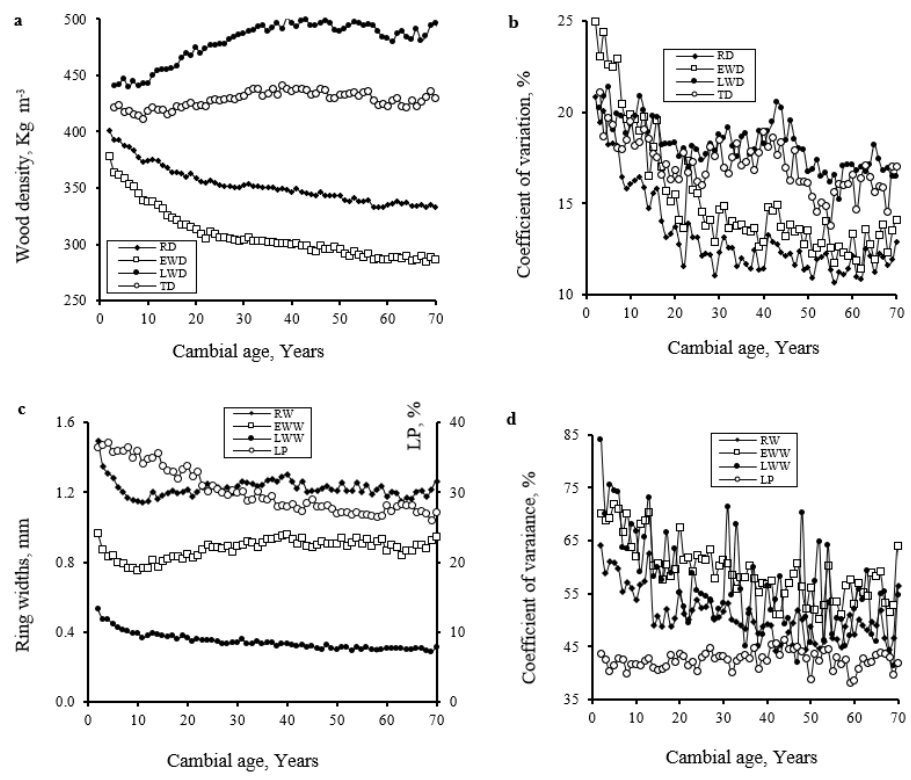
Figure 2. Means ( a , c ) and coefficient of variations ( b , d ) of annual ring density (RD, kg m − 3 ), ear- lywood density (EWD, kg m − 3 ), latewood density (LWD, kg m − 3 ), transition density (TD, kg m − 3 ), ring (RW, mm), earlywood (EWW, mm), latewood width (LWW, mm), and latewood proportion (LP, %) as related to cambial age (from the pith) at breast height in 287 Thuja occidentalis trees growing in Abitibi Témiscamingue, Québec, Canada.